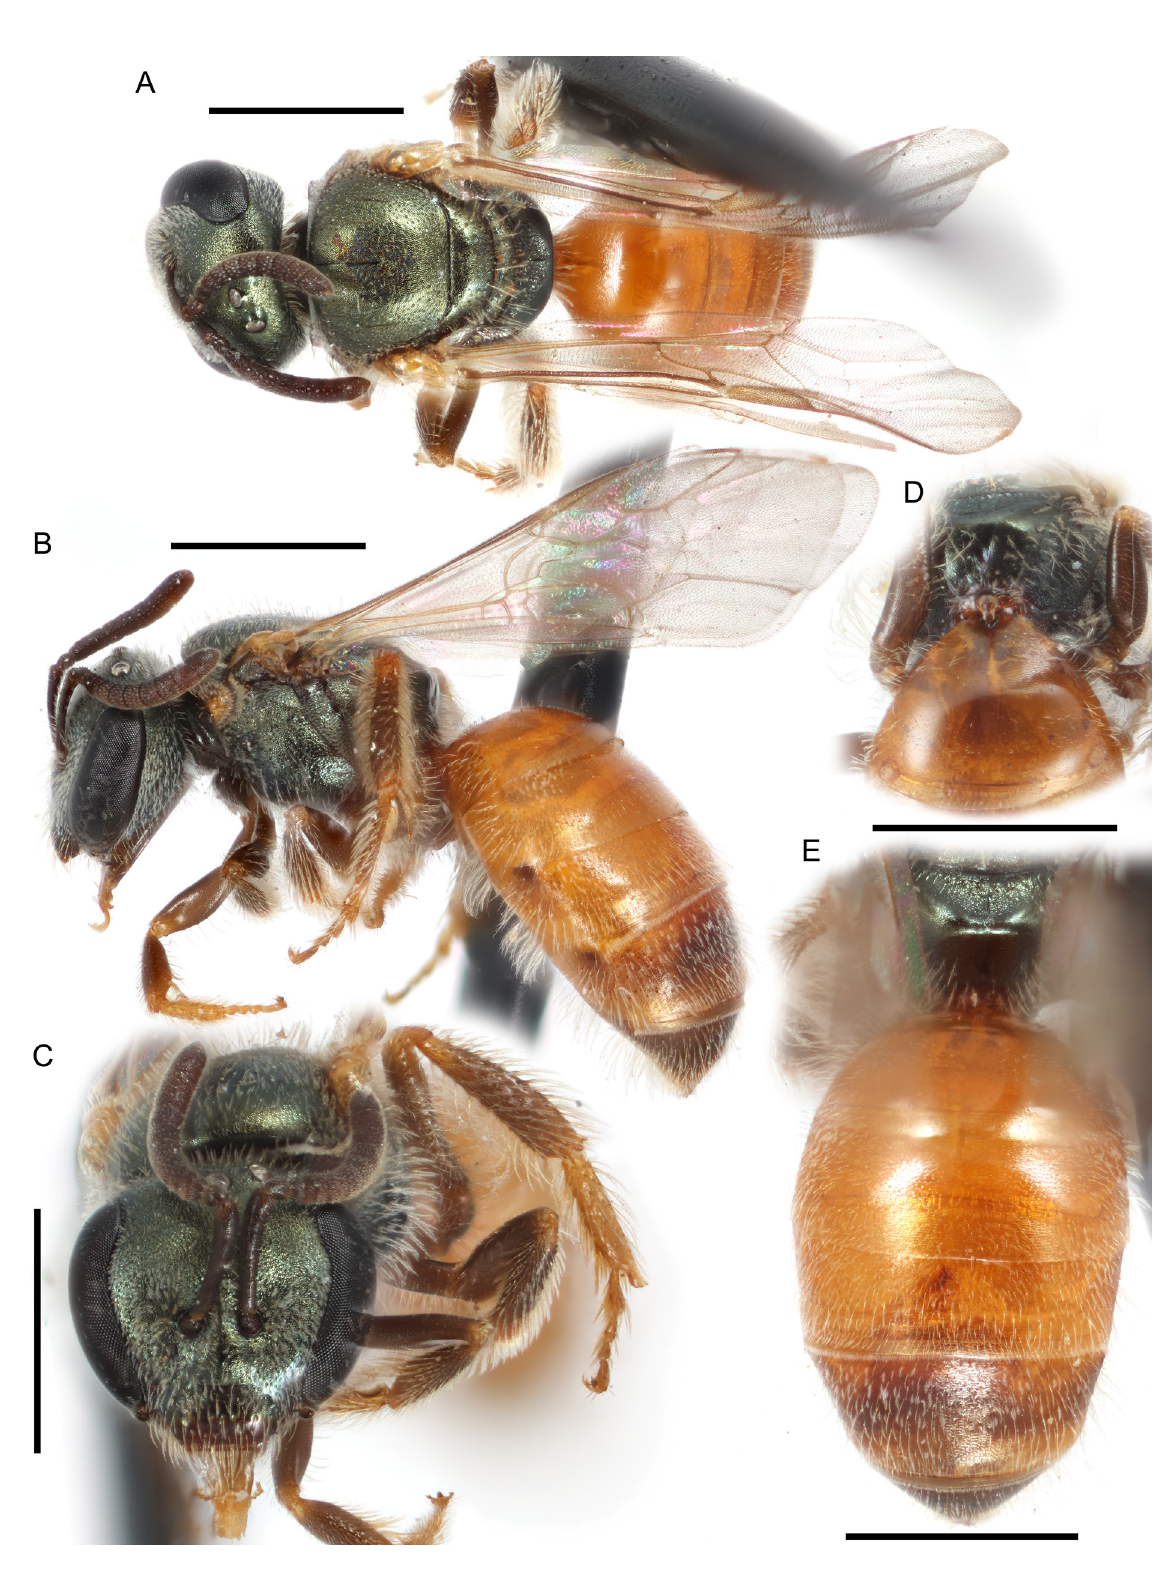
Fig. 58. Lasioglossum ( D. ) meteorum sp. nov., ♀. A . Dorsal habitus. B . Lateral habitus. C . Face. D . Propodeum. E . Metasoma. Scale bars: 1